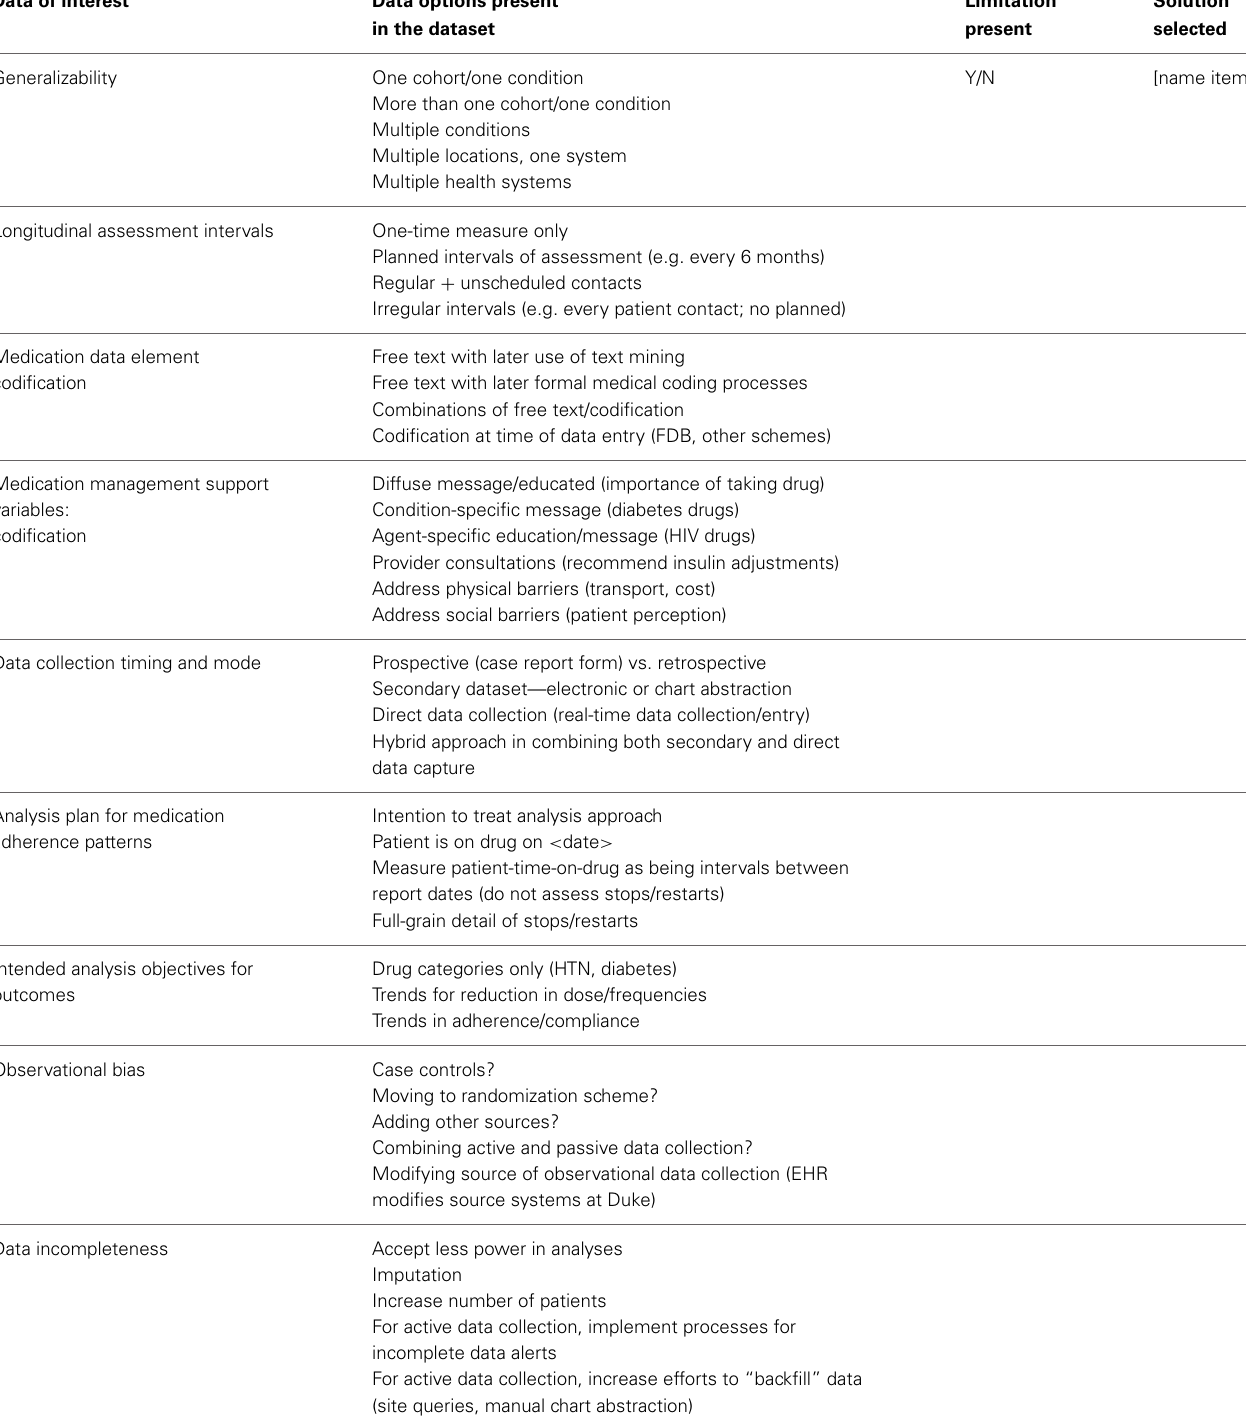
Table 1B | Process matrix: considerations for analysis limitations for medication adherence